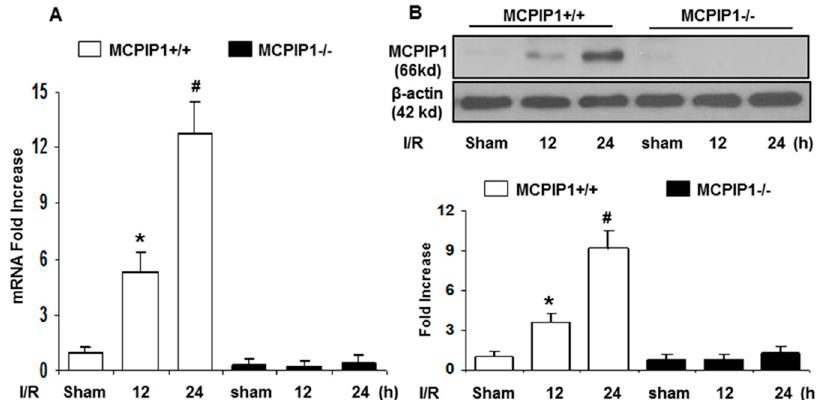
Figure 1. Monocyte chemotactic protein 1–induced protein 1 (MCPIP1) mRNA and protein levels are elevated in the murine brain subjected to ischemia / reperfusion (I / R) injury. ( A ) MCPIP1 mRNA expression in the mouse brain with I / R insult was measured by qRT-PCR. Values represent mean ± SD, * p < 0.05, # p < 0.01 versus sham-operated controls; n = 6 per group. ( B ) MCPIP1 protein levels in mouse brain with I / R insult were measured by western blot. Results are representative of three independent experiments. Values represent mean ± SD, * p < 0.05, # p < 0.01 versus sham-operated controls; n = 6 per group.